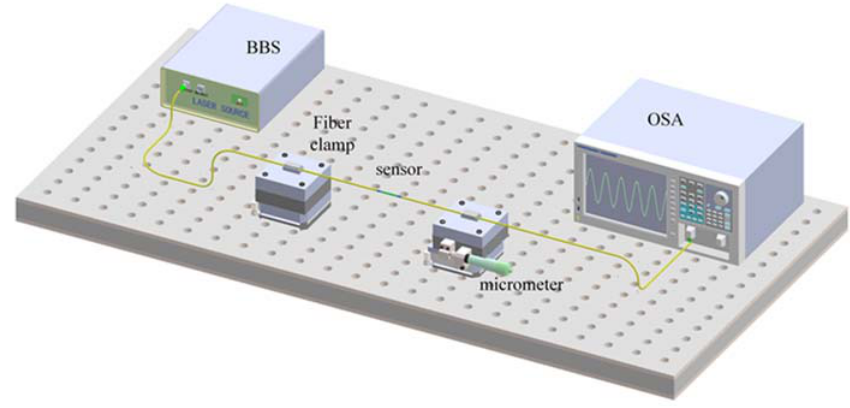
Figure 8. Measurement system for strain sensing.